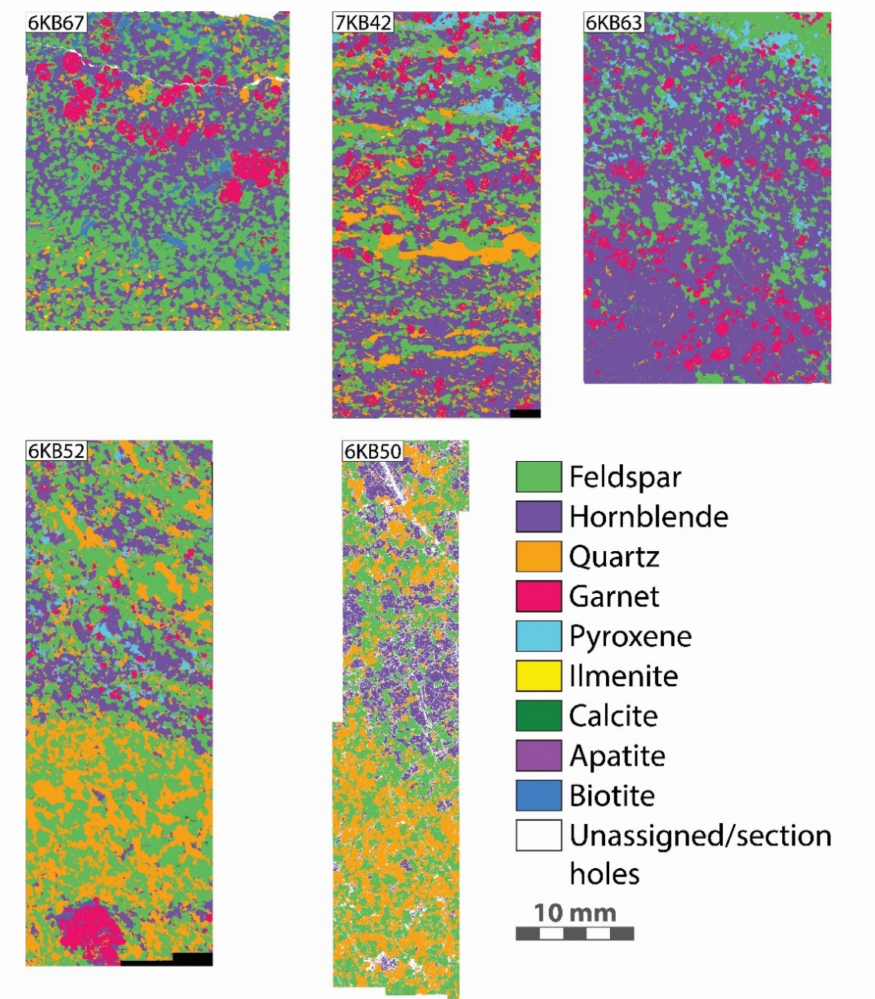
Figure 2. Simplified mineral phase maps of the KSZ gneiss samples obtained by scanning electron microscope electron-dispersive spectroscopy (SEM-EDS)